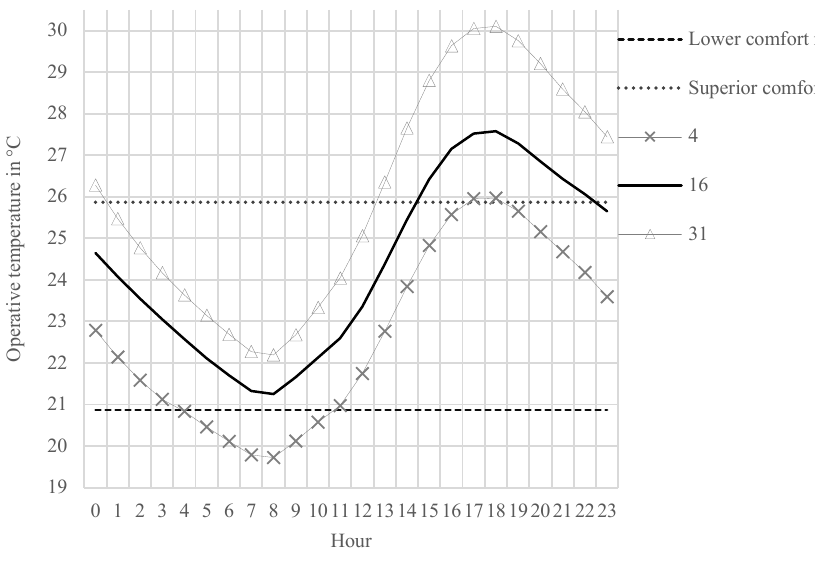
Fig. 4. Operative temperature behaviour in Season A.